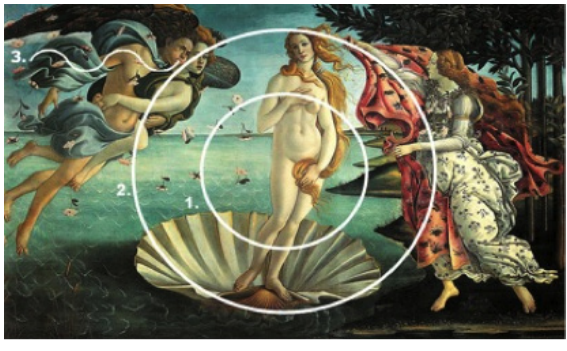
FIGURE 2 | ‘Content and Form’: 1 - Form; 2 - Content; 3 - Mnemonic